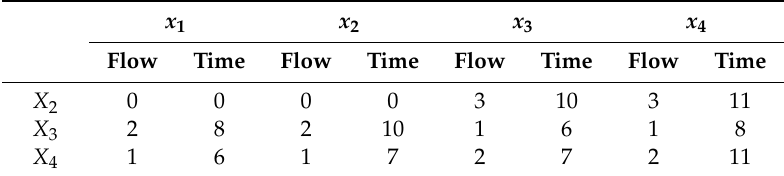
Table 14. Transport time and flow for each arc.